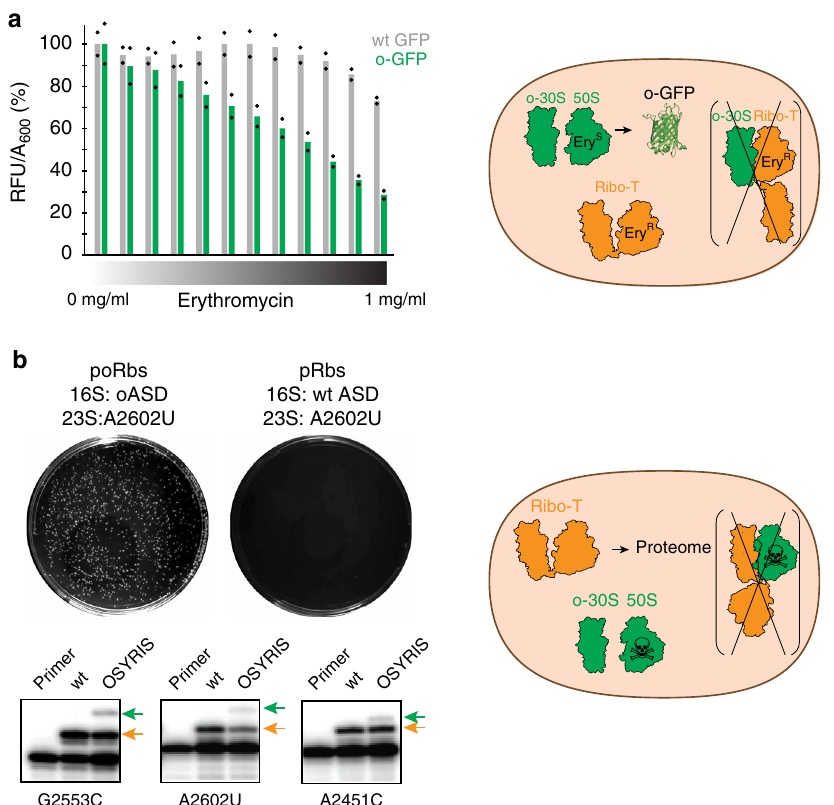
Fig. 5 The orthogonality of the small and large subunits of the dissociable o-ribosome in the OSYRIS cells. a Expression of the o-GFP reporter in the OSYRIS cells is inhibited by erythromycin (left, green bars) demonstrating that it is translated primarily by the dissociable oRbs but not by the Ribo-T/30S hybrid (cartoon on the right). The bar graph represents the mean of two biological replicates with individual data points indicated by black dots. The raw data can be found in the Source data fi le. b Top: OSYRIS cells transformed with a poRbs plasmid with the lethal mutation A2602U are able to form colonies (left plate), revealing that the large subunit of the oRbs is excluded from the translation of the cellular proteome. The dominant lethal nature of the A2602U mutation in a non-orthogonal translation system is demonstrated by the lack of colonies when OSYRIS cells are transformed with the same plasmid but with unaltered (wt) ASD in the 16S rRNA gene (pRbs) (right plate) (see also Supplementary Fig. 7b, c). Bottom: primer extension analysis demonstrates that the OSYRIS cells stably maintain the large ribosomal subunits with 23S rRNA mutations that would be dominantly lethal in wt E. coli cells. cDNA bands representing mutant 23S rRNA (green arrows) or Ribo-T rRNA (orange arrows) are indicated. Co-existence of Ribo-T (with G2058) with dissociable ribosomes with lethal 23S rRNA mutations (but wt adenine at position 2058) was further con fi rmed by primer extension analysis around the 2058 rRNA residue (Supplementary Fig. 7d). Right: cartoon illustrating the conclusions from these experiments which argue that the dissociable 50S subunits are largely isolated from the translation of the cellular proteome whose expression relies on Ribo-T. The data represent the results of three independent biological replicates. The uncropped gel can be found in the Source data fi